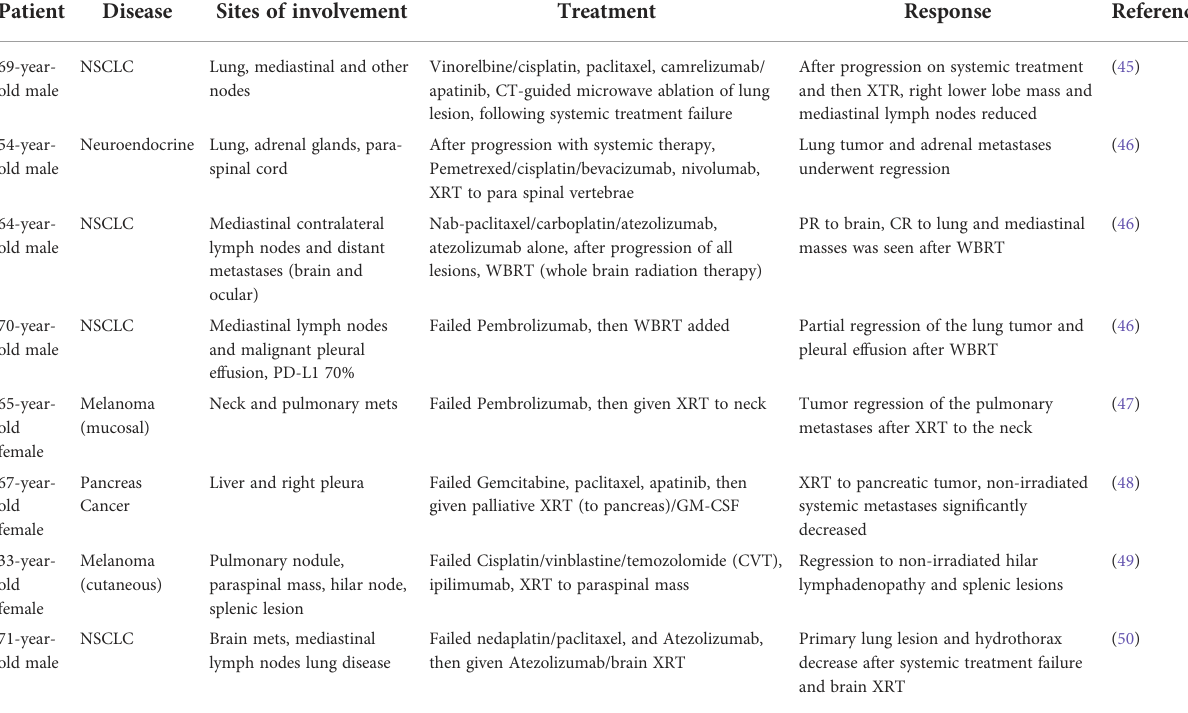
TABLE 2 Abscopal case reports of irradiation and systemic treatment following systemic treatment failure.